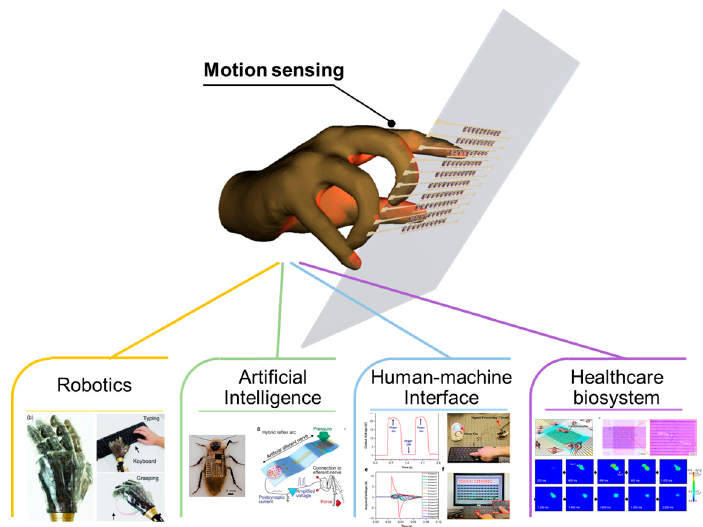
Figure 1. Tactile sensors for motion sensing. Reproduced with permission [24]. Copyright 2014, Springer Nature. Reproduced with permission [9]. Copyright 2018, American Association for the Advancement of Science. Reproduced with permission [10]. Copyright 2015, American Chemical Society. Reproduced with permission [25]. Copyright 2020, American Chemical Society.